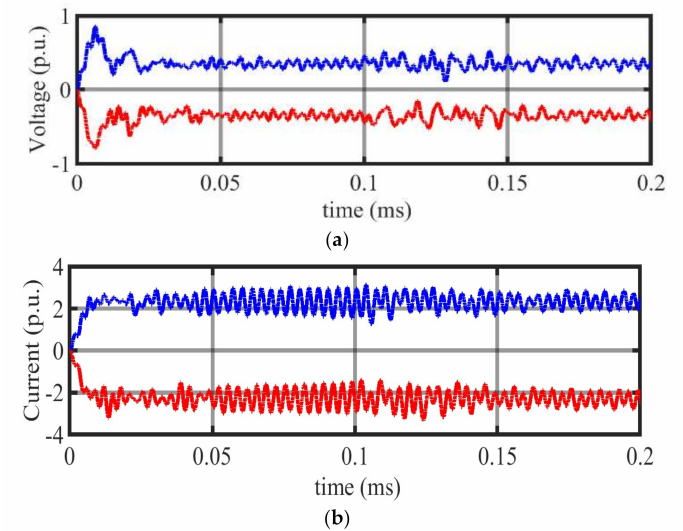
Figure 26. ( a ) DC Voltage and ( b ) DC current profiles under PP fault occurred at 200 km from RS-I Line